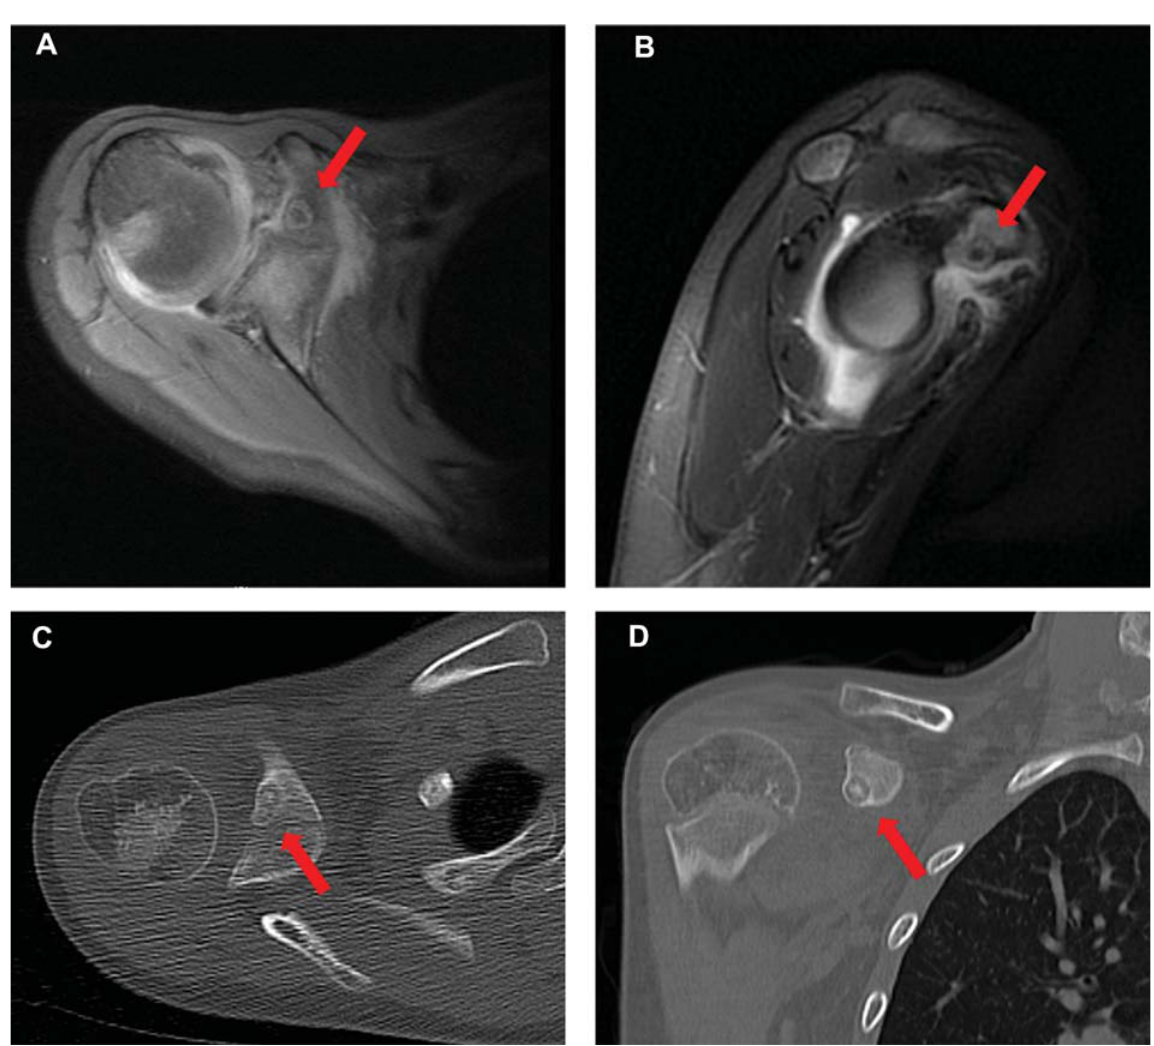
Fig. 2 T2-weighted magnetic resonance imaging (MRI) and computed tomography (CT) images of the right shoulder demonstrating an osteoid osteoma. Red arrows point to location of lesion. ( A ) Axial MRI image. ( B ) Sagittal MRI image. ( C ) Axial CT image. ( D ) Sagittal CT image.